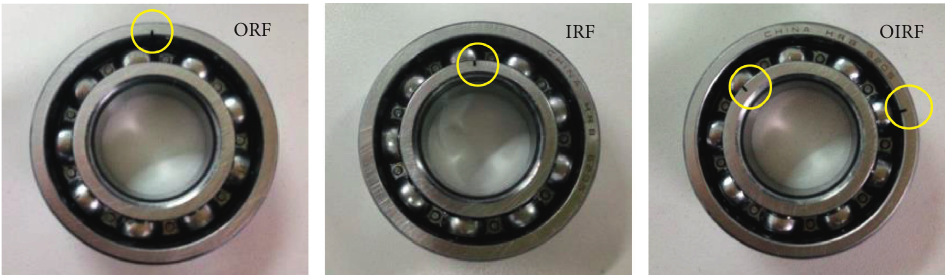
Figure 25: Three fault conditions of rolling bearing. (a) ORF, (b) IRF, and (c) OIRF. Table 10: The parameters of rolling bearing. Bearing type Roller diameter (mm)